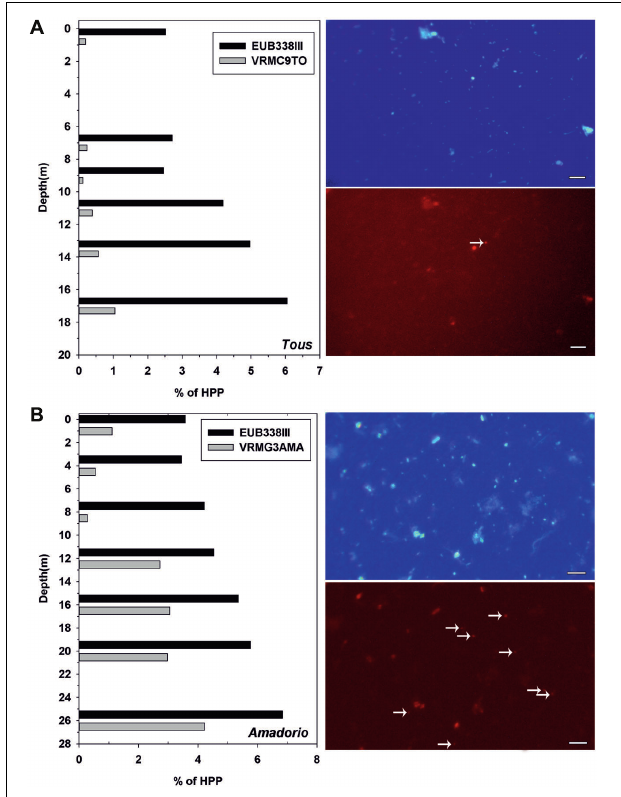
FIGURE 3 | (Left), relative abundance (%) of total Verrucomicrobia (Eub338III) and specific Verrucomicrobia-Tous-C9LFEB (VrmC9to, 4.63 Mb of estimated genome size) and Opitutae-AMD-G3 (VrmG3Ama, 2.13 Mb of estimated genome size) relative to total heterotrophic picoplankton (HPP) for (A) Tous and (B) Amadorio reservoirs. (Right), microscopic fluorescence in situ hybridization images of samples from (A) Tous reservoir and (B) Amadorio reservoir. The micrographs show two pairs of identical microscopic fields, with samples stained with DAPI (up) and with the specific designed probes labeled with Cy3 (down). White arrows mark VrmC9To (A) and VrnG3Ama (B) . Bar: 5 µ m (all four